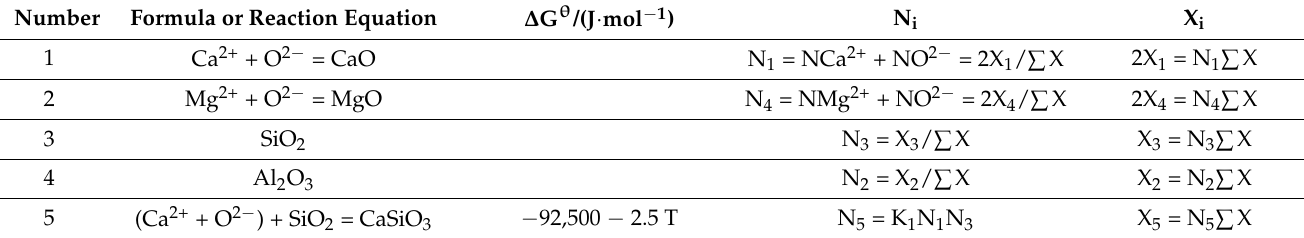
Table 2. Thermodynamic data for complex slag component chemical reactions and the corresponding chemical equilibrium